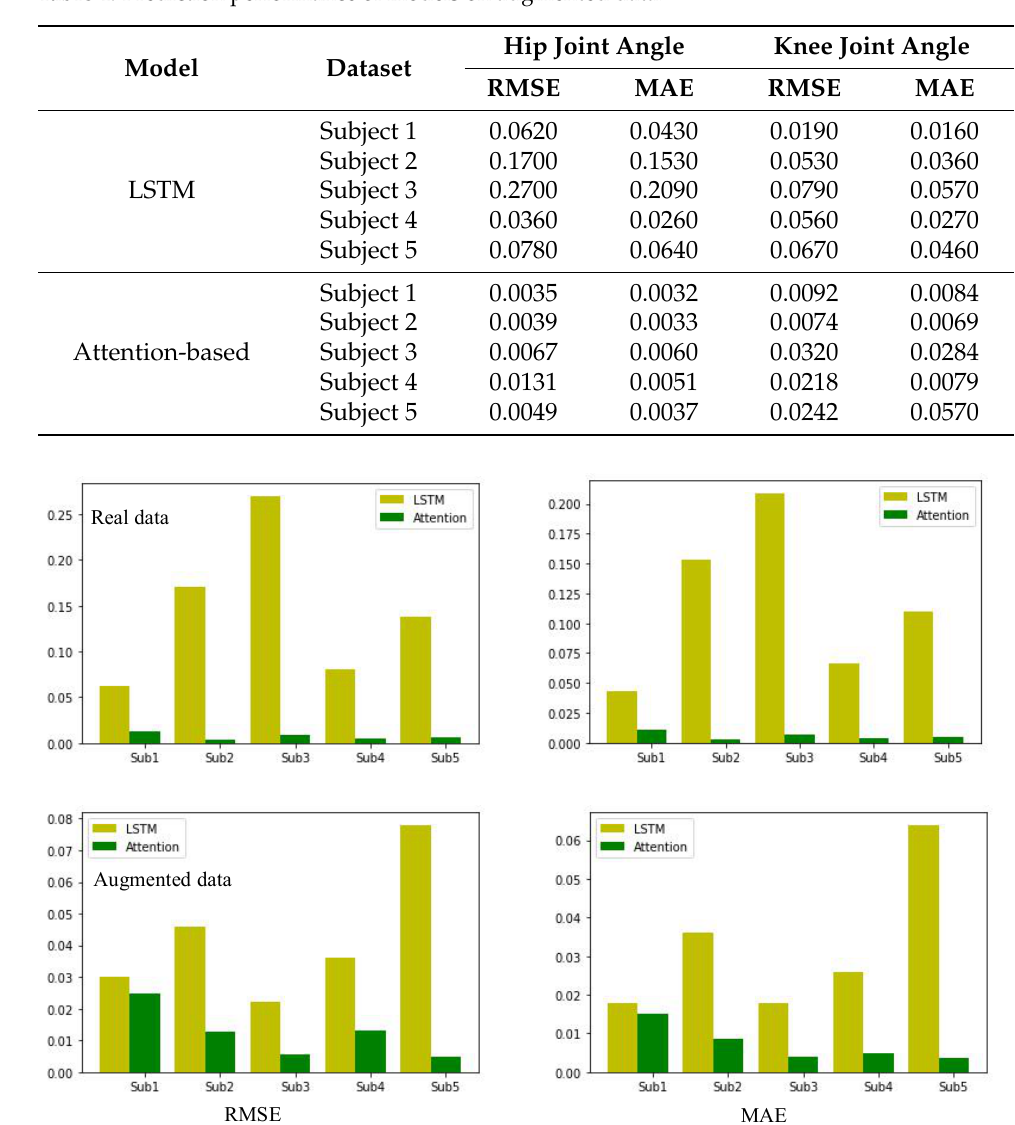
Table 4. Prediction performance of models on augmented data.